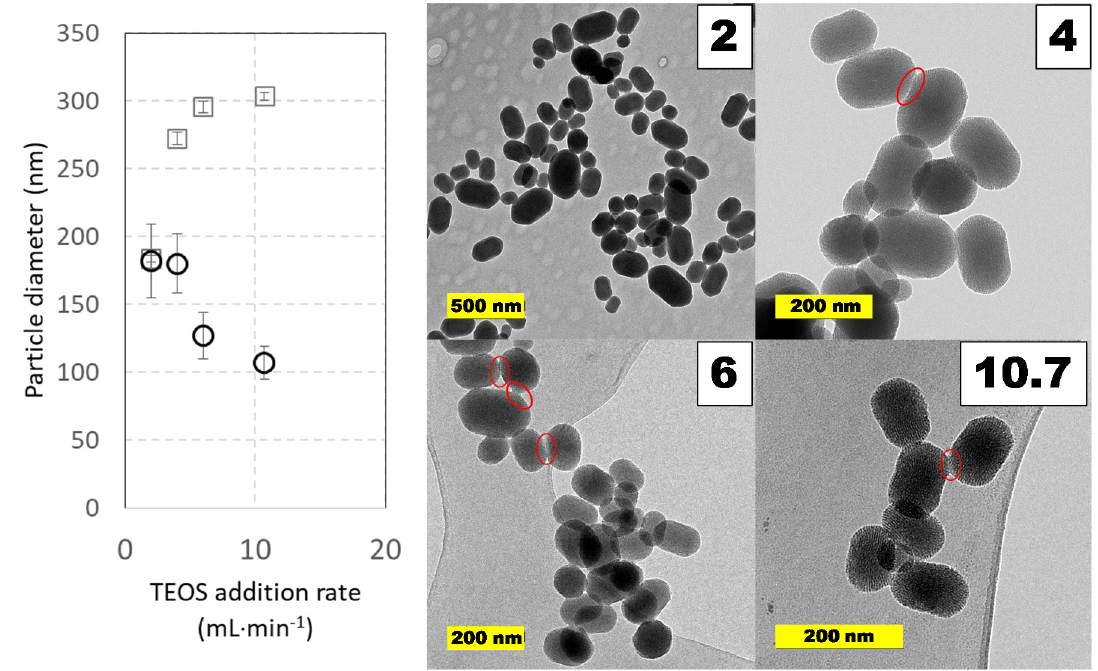
Figure 7. Particle size distributions and TEM images of MCM-41 MSNs prepared in pilot-plant scale under different reagent’s addition rates. Squares ( ) are used for hydrodynamic diameters measured by DLS values and circles ( ) for diameters measured on TEM micrographs. Experimental conditions: 5 L jacketed cylindrical reactor with 4 L working volume with a Rushton turbine as overhead stirrer (650 rpm). Reactions were carried out at 60ºC using TEOS (40 mL) and CTAB (8 g, 2 g ⋅ L -1 ) during 60 min at 650 rpm. Red elliptical contours show possible coalescence contacts between nanoparticles. Data shown correspond to samples 345.3, 349.2, 349.1, 345.7, and 345.6 in Table S1 of Supplementary Materials.